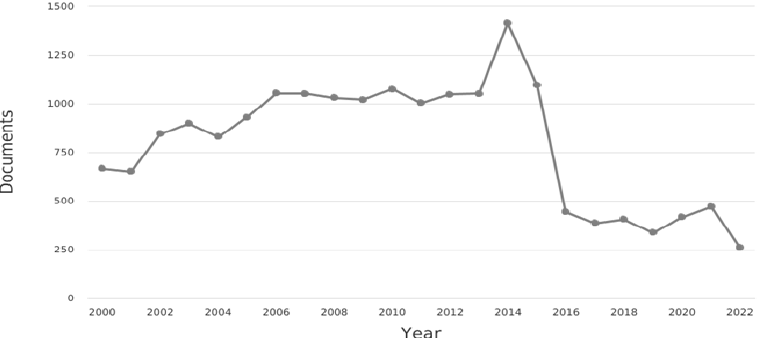
Figure 1. The number of publications between 2000 and 2022.